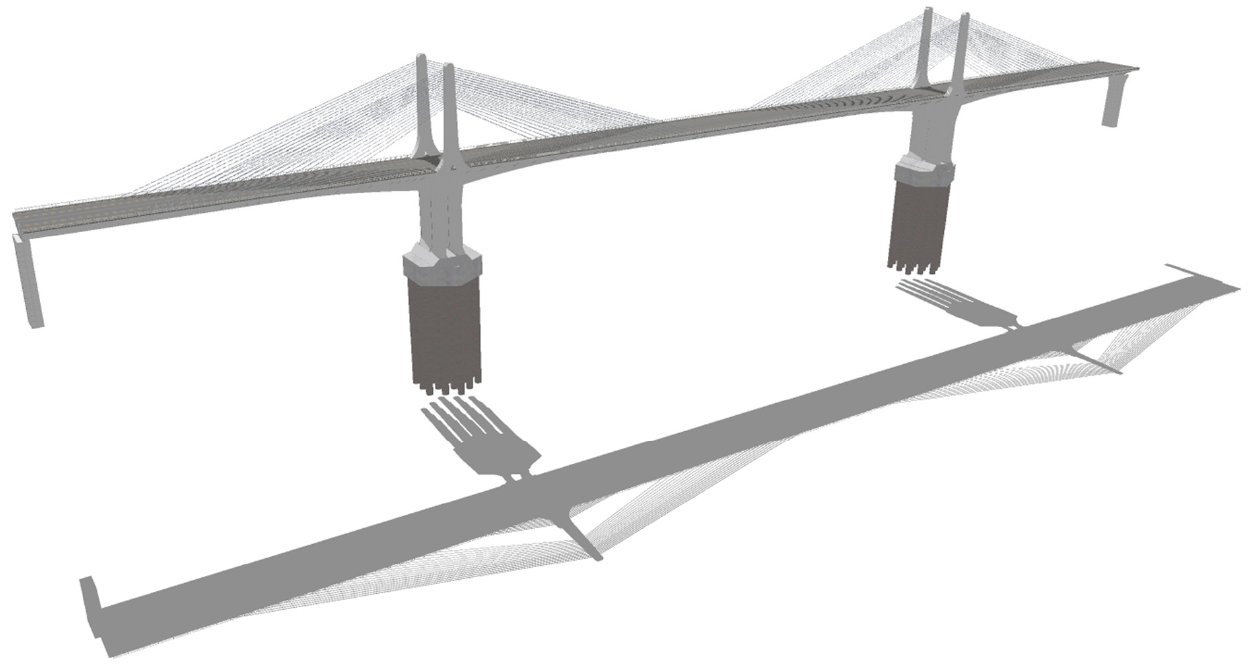
Figure 13. Bridge Overall Model.